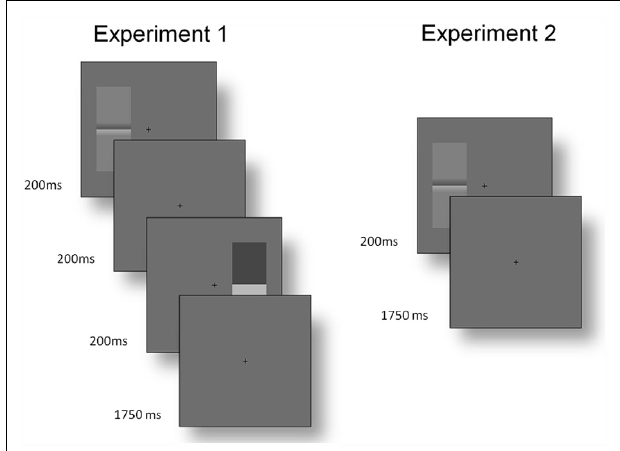
FIGURE 10 |Time courses of trials. Experiment 1: before the start of each trial, participants fixated a central cross. One Cornsweet and one real luminance step stimulus appeared for 200ms each, with a 200ms interval between them.The order of the stimuli, their orientation and the side on which each appeared were randomized (although they were constrained to appear on opposite sides within each trial). Participants then had 1750ms to report the side on which the stimulus with the greatest contrast had appeared (using the arrow keys of the keyboard). Experiment 2: each trial stared with fixation. A Cornsweet stimulus then appeared for 200ms with a random orientation to the left or right of fixation. Participants had 1750ms to report, with the “Y” and “N” keys, if they perceived Mach bands.